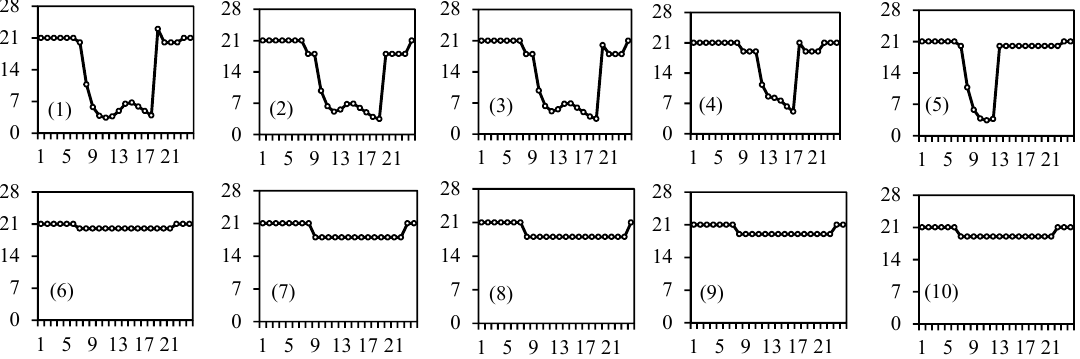
Figure 14. Environmental control of greenhouse in winter season: ( a ) temperature; ( b ) humidity; and ( c ) CO 2 concentration. Energies 2018 , 11 , x